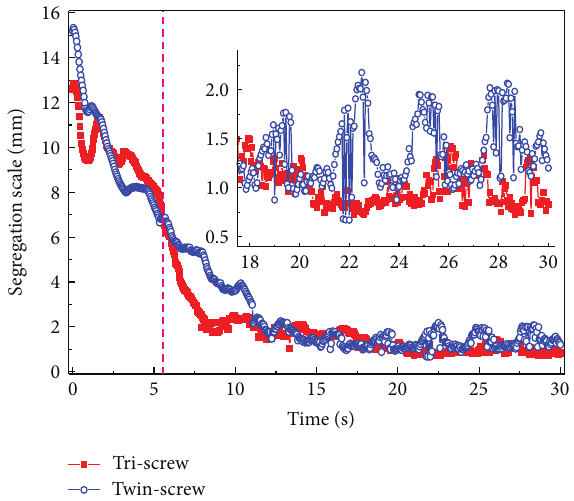
Figure 11: Cluster distribution index at three